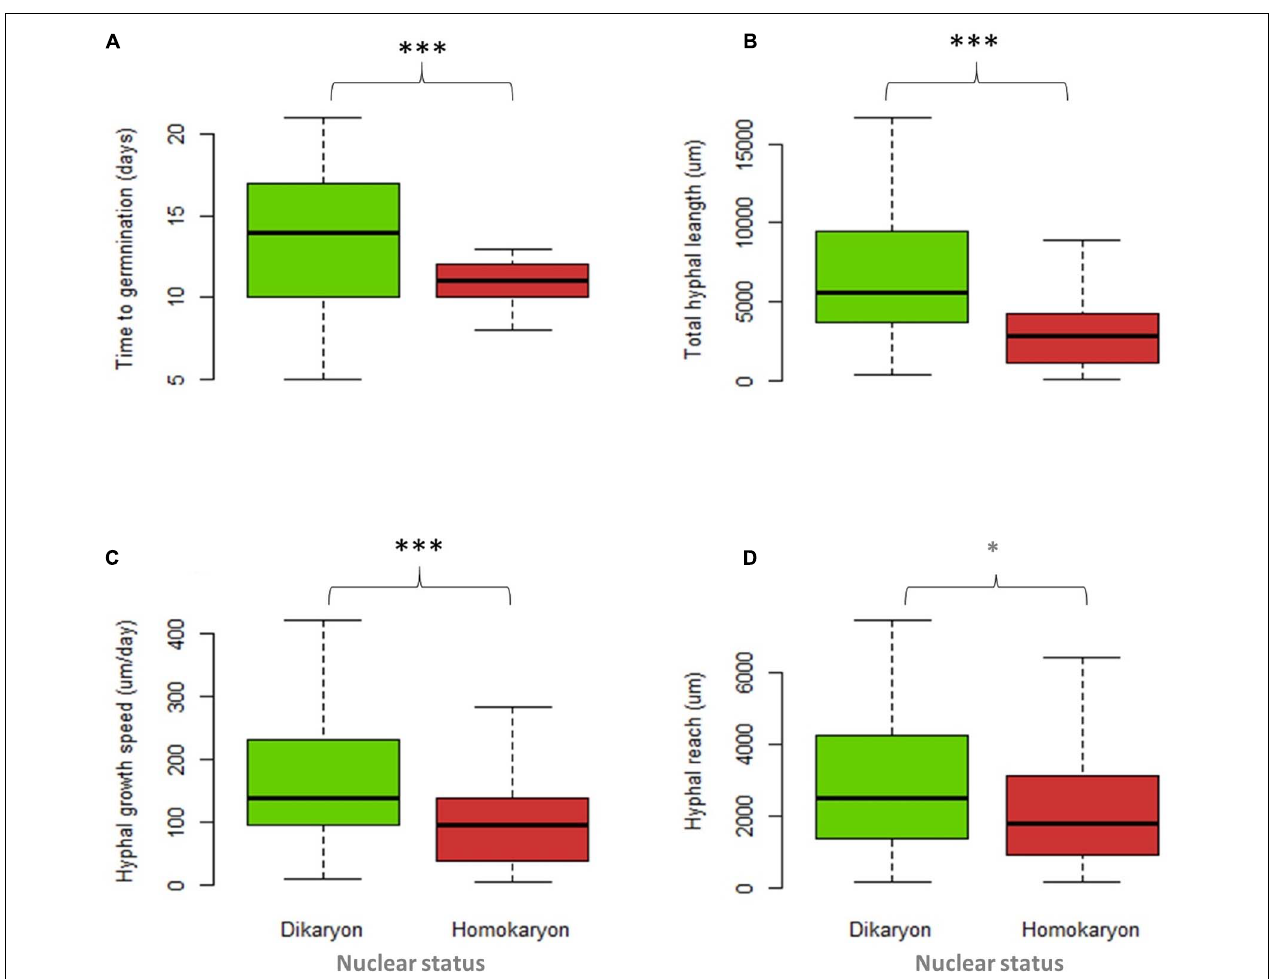
FIGURE 4 | Trait variation between four dikaryotic (green) and five homokaryotic (red) strains of Rhizophagus irregularis during the asymbiotic growth stage. (A) Time to germination, (B) total hyphal length, (C) hyphal growth speed, and (D) hyphal reach. Statistical significance was evaluated using the non-parametric Kruskal–Wallis test. The asterisks indicate statistical significance at p < 0.001. The boxplots show the first and third quartile (box edges), median (middle line), and the data range (min/max = whiskers).